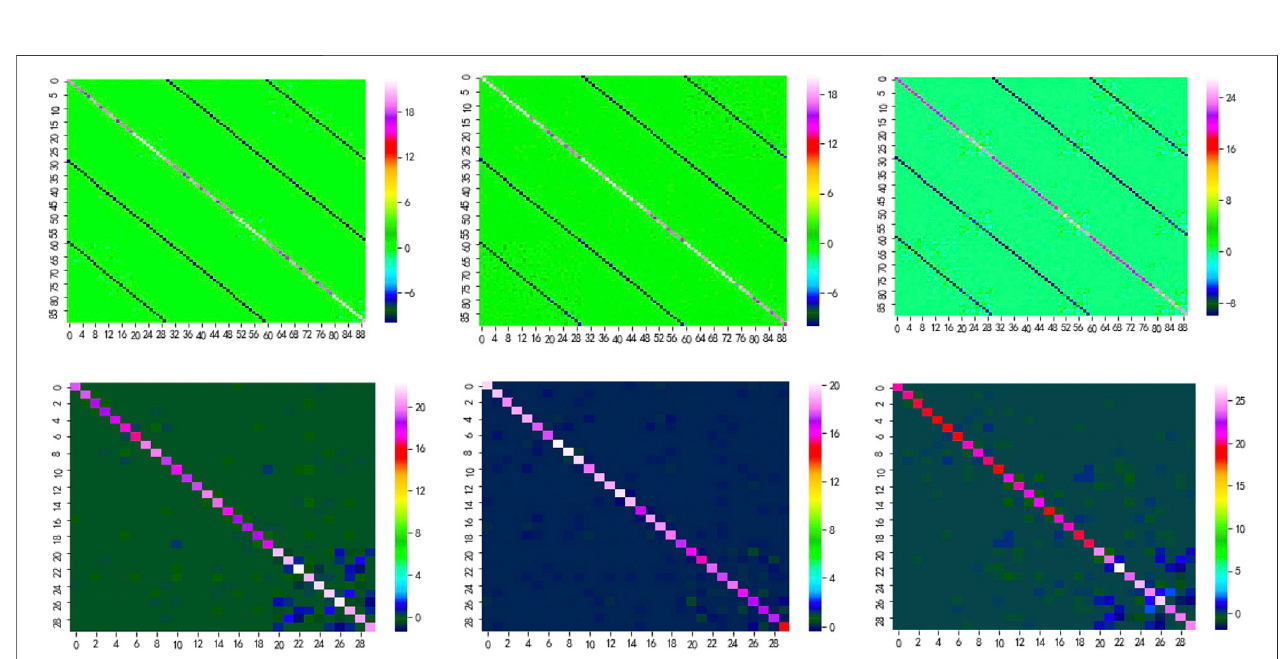
FIGURE 8 | The patterns of sparse inverse covariance matrix estimated by TICC